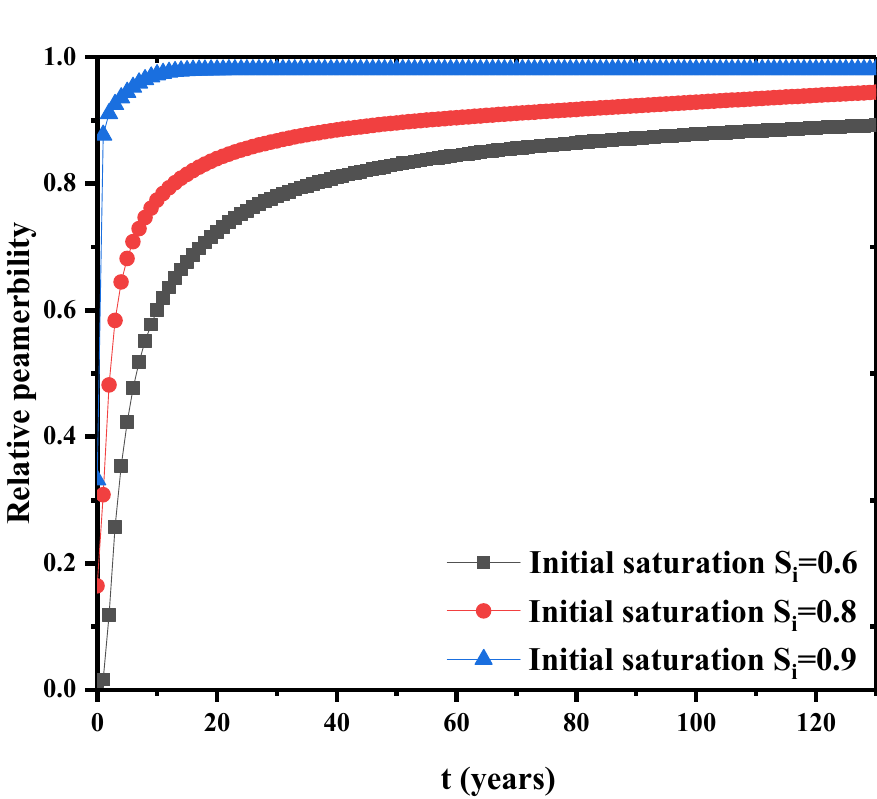
Figure 9. Change of relative permeability at the bottom under different initial saturations.